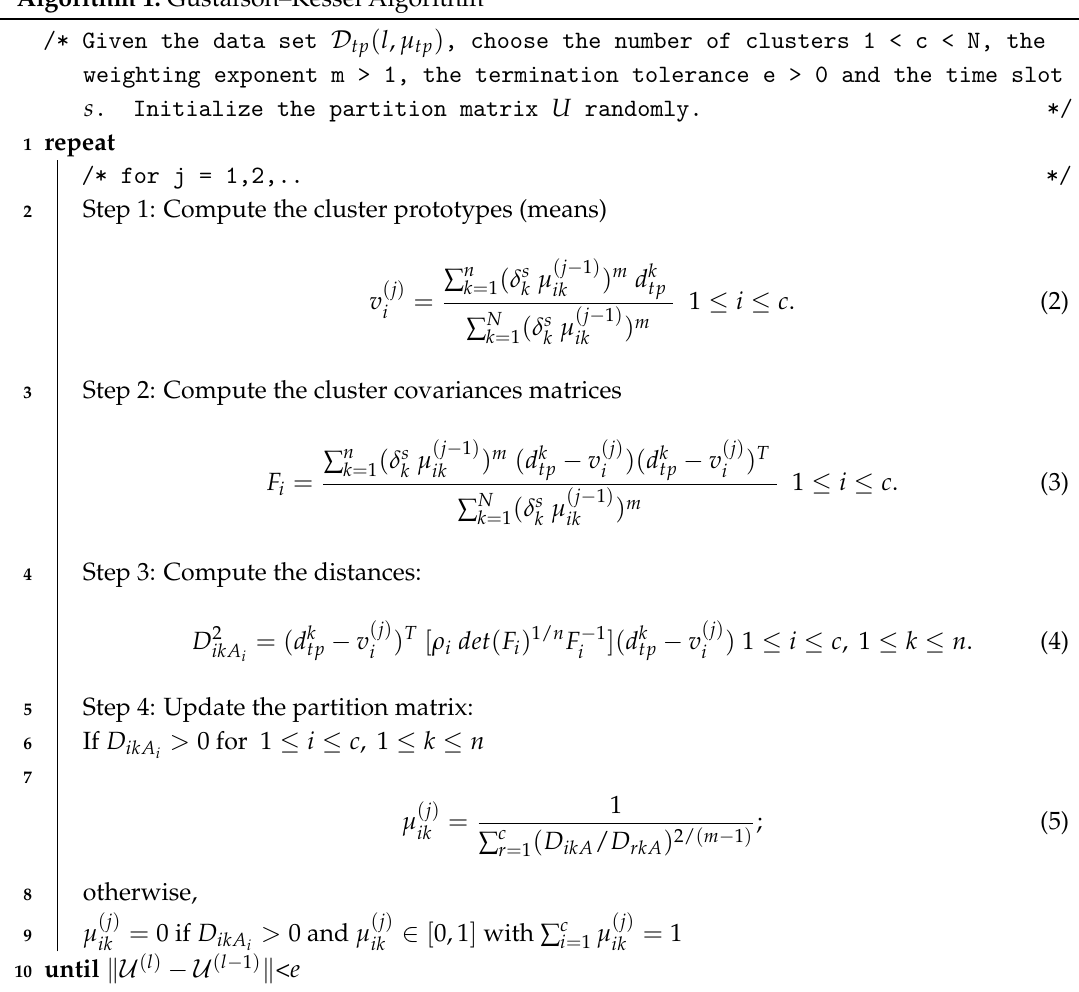
Algorithm 1: Gustafson–Kessel